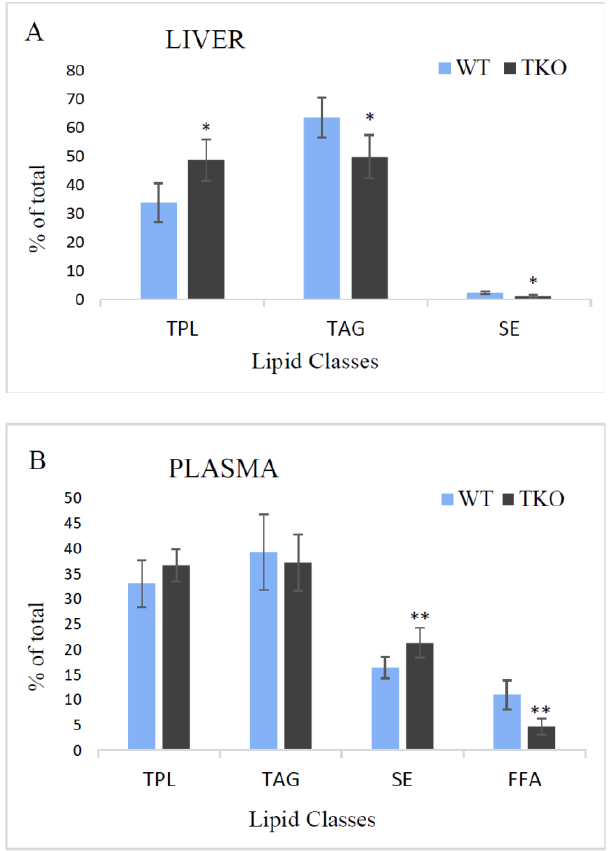
Figure 2. The relative concentrations (% of total) of the major lipid classes in liver ( A ) and plasma ( B ) from wild-type (WT) and triple-synuclein knockout mice: the total polar lipids (TPL), triacylglycerols (TAG), steryl esters (SE), and free (non-esterified) fatty acids (FFA). Values represent means ± s.d. ( n = 6). * p < 0.05, ** p < 0.01.